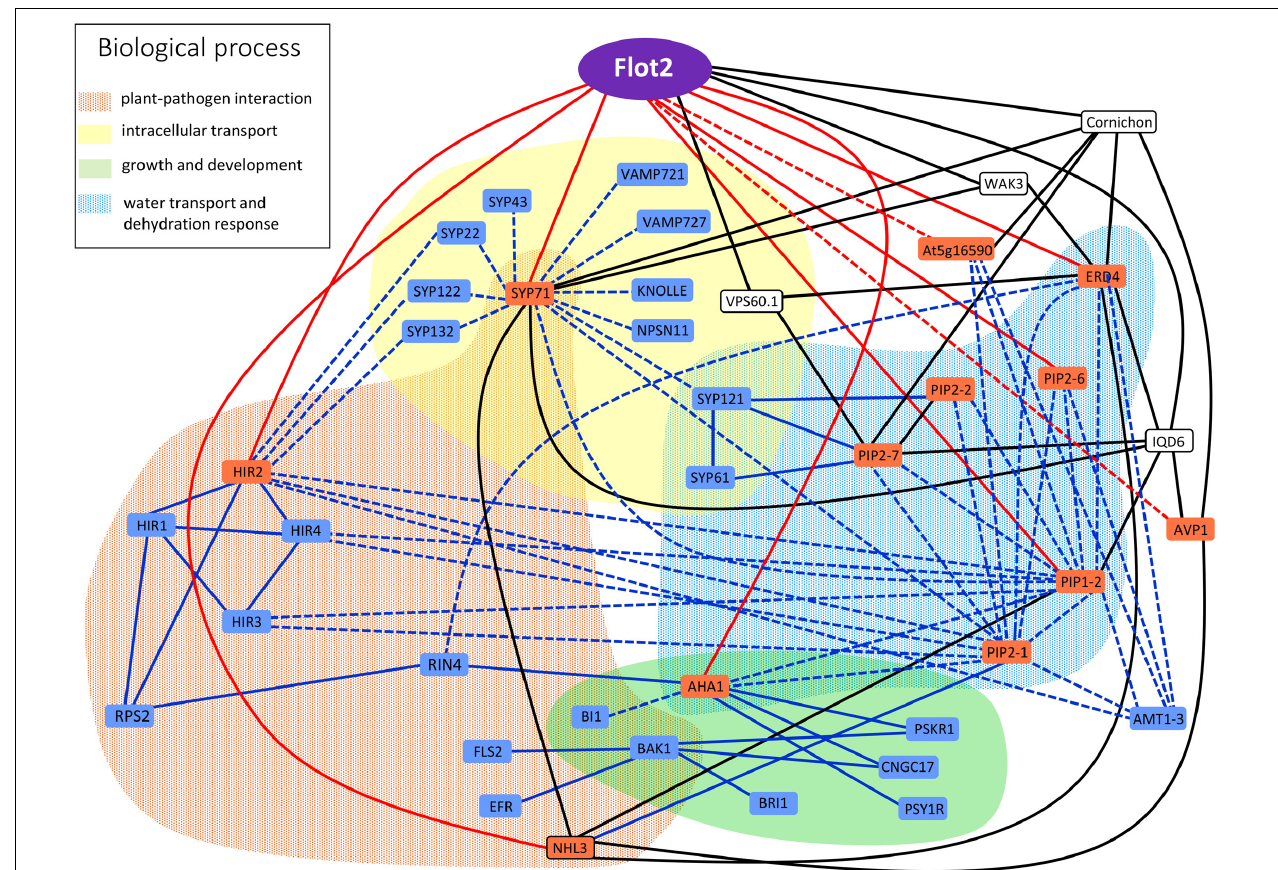
FIGURE 5 | Graphical representation of Flot2 interaction network. Interactors experimentally determined in our study are displayed in red boxes. Solid red lines represent direct binding with Flot2 verified by SUS, while dashed red lines depict putative indirect interactions with Flot2 with negative SUS results. Blue boxes and lines represent direct (solid lines) or indirect (dashed lines) interactions published in literature and mentioned in discussion. Pair–wise interactions confirmed by yeast two hybrid or split ubiquitin assay, bimolecular fluorescence complementation or FRET/FLIM measurement are assumed as direct. Proteins found in co-IP assays and determined by mass spectrometry or revealed in tagged-protein pull-down assays, which were neither tested nor confirmed to be direct (by the methods listed above), were considered putative indirect interactors. Black boxes and lines represent most common direct interactions retrieved from Associomics database, which are common to several proteins detected in our study as well as Flot2. The implication of interactors in important biological processes is distinguished by colored fields.